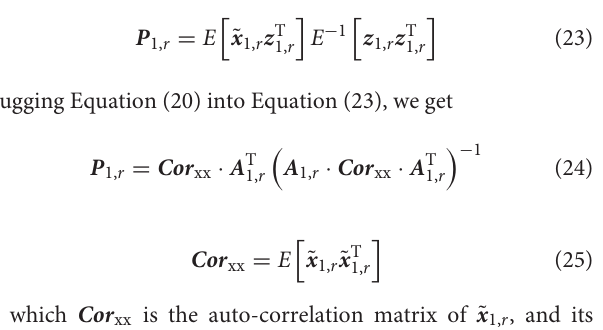
Frontiers in Plant Science |